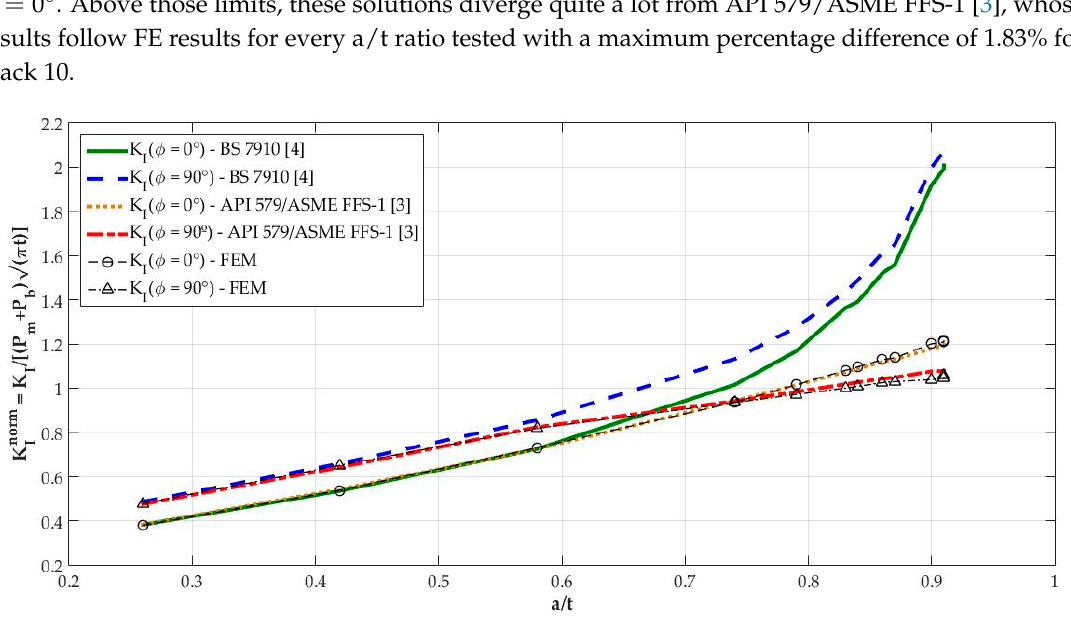
Figure 18. Normalized mode I SIF values versus a/t ratio.